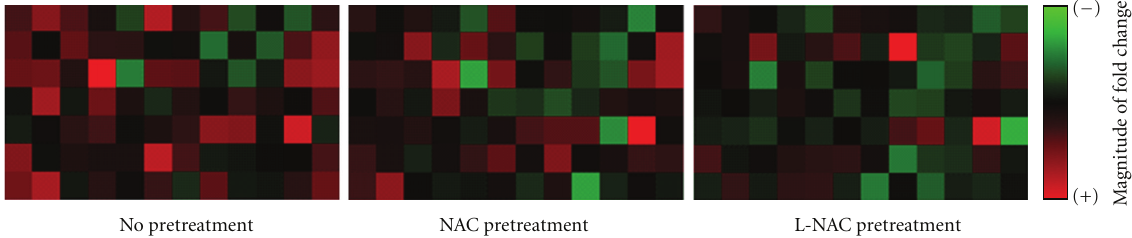
Figure 6: E ff ect of NAC or L-NAC pretreatment on the magnitude of gene expression in PQ-challenged cells. RNA was extracted from cells challenged with 0 or 0.25mM PQ for 4h following pretreatment with 5.0 mM NAC- or L-NAC-containing media and analyzed via quantitative reverse-transcription PCR using a gene array. The magnitude of expression of each gene is expressed on a scale ranging from minimal (intense green) to maximal (intense red) expression ( n = 3 independent experiments).